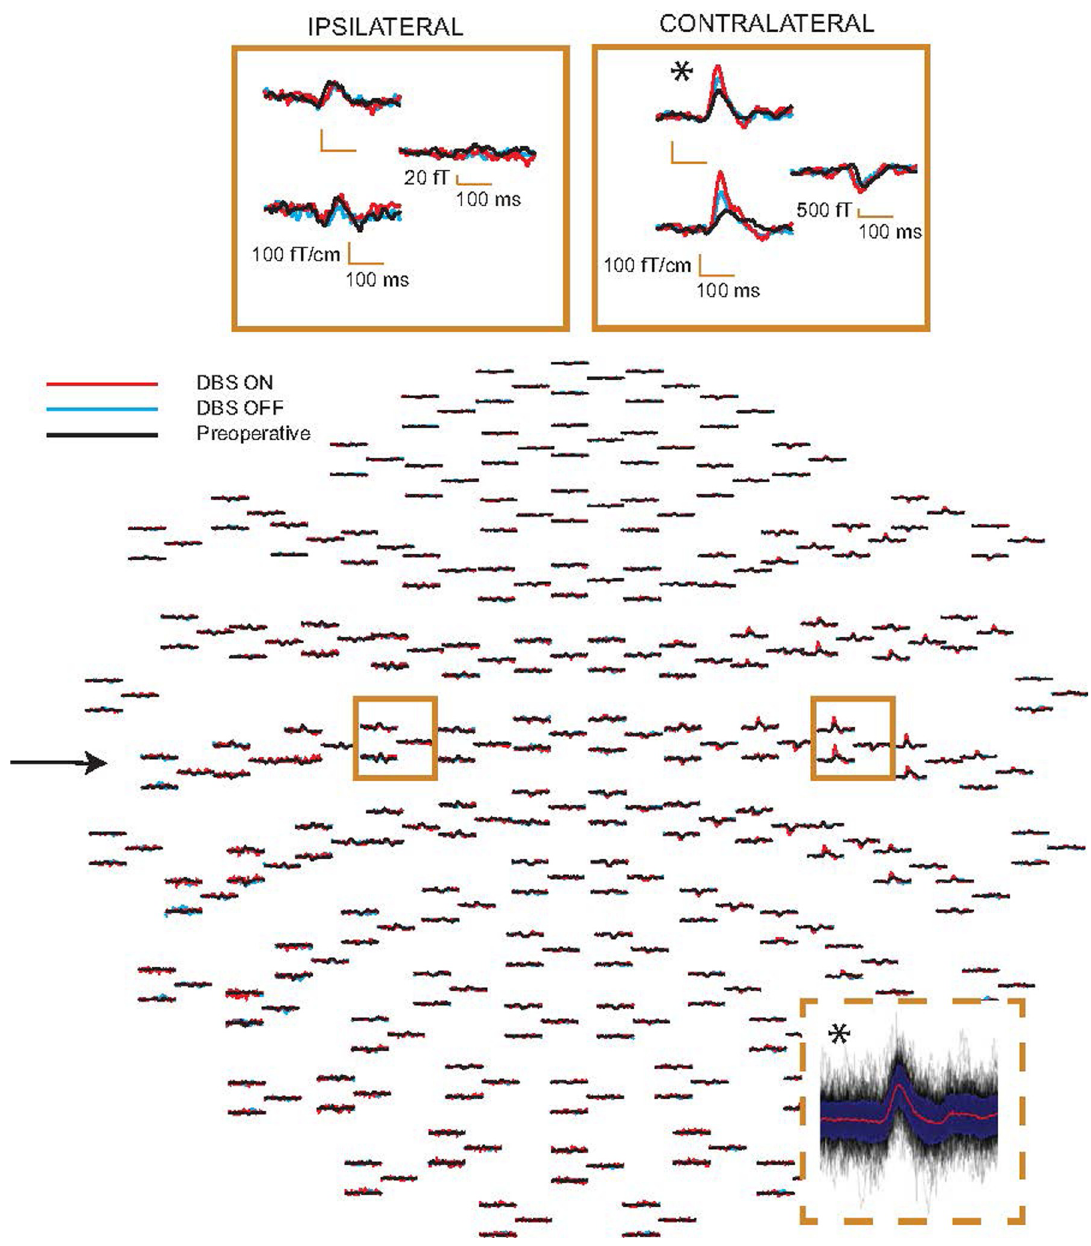
Fig 1. Sensor level data in one patient. Auditory responses to left-ear stimulation measured before DBS implantation (preoperative) and after the implantation, both DBS on and off. The arrow indicates the stimulated (left) ear, and the inserts (above) depict the maximum channels in the contra- and ipsilateral hemispheres. At each sensor triplet, the two left-sided sensors are gradiometers, and the right-sided one is a magnetometer. The insert (below) demonstrates the single-trial responses (black), their mean (red) and ± 1 SD (dark blue) in the preoperative condition at the maximum gradiometer channel (marked with asterisk).